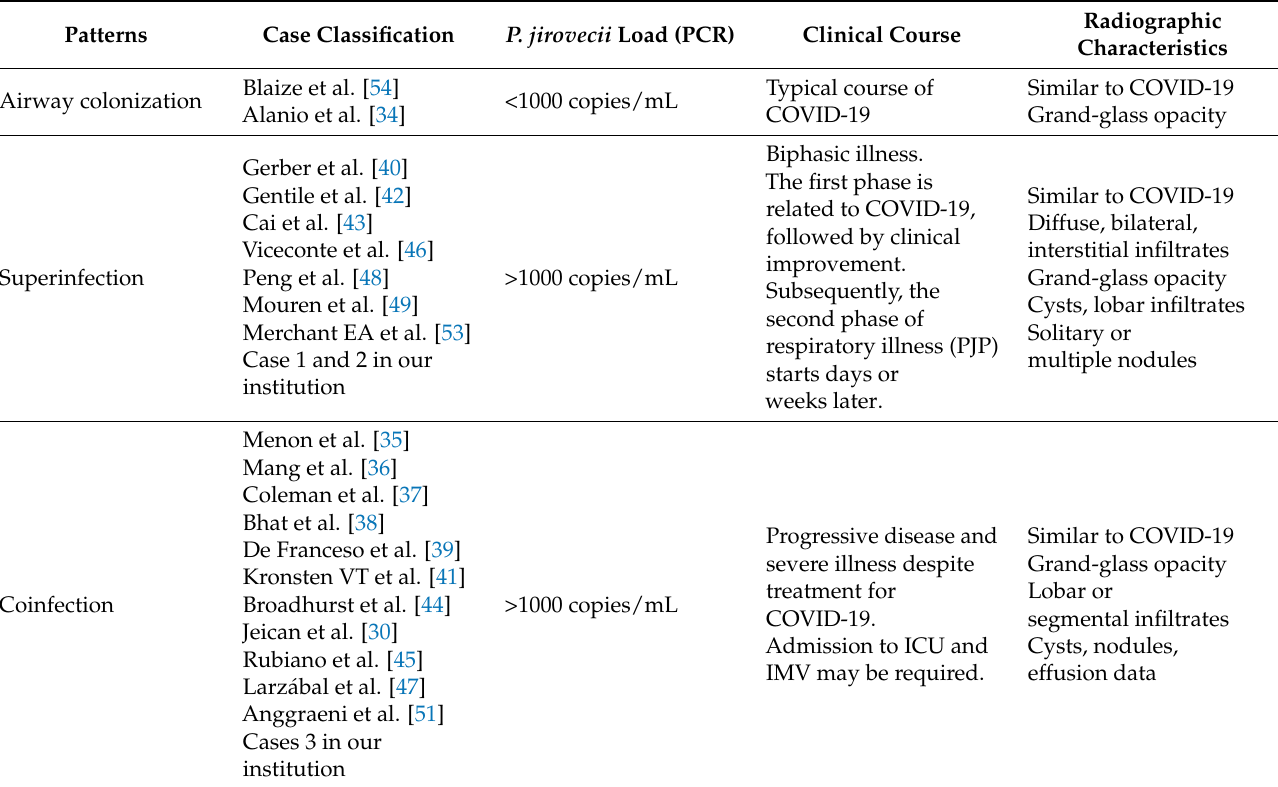
Table 2. Patterns of COVID-19 and P. jirovecii colonization, coinfection, and